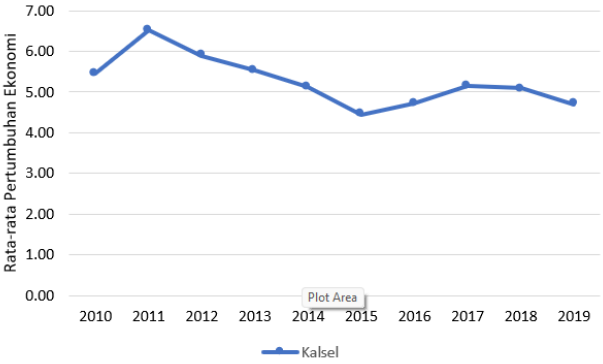
Figure 2: Average Economic Growth in South Kalimantan in 2010-2019 Convergence and Determinants of Economic Growth in South Kalimantan